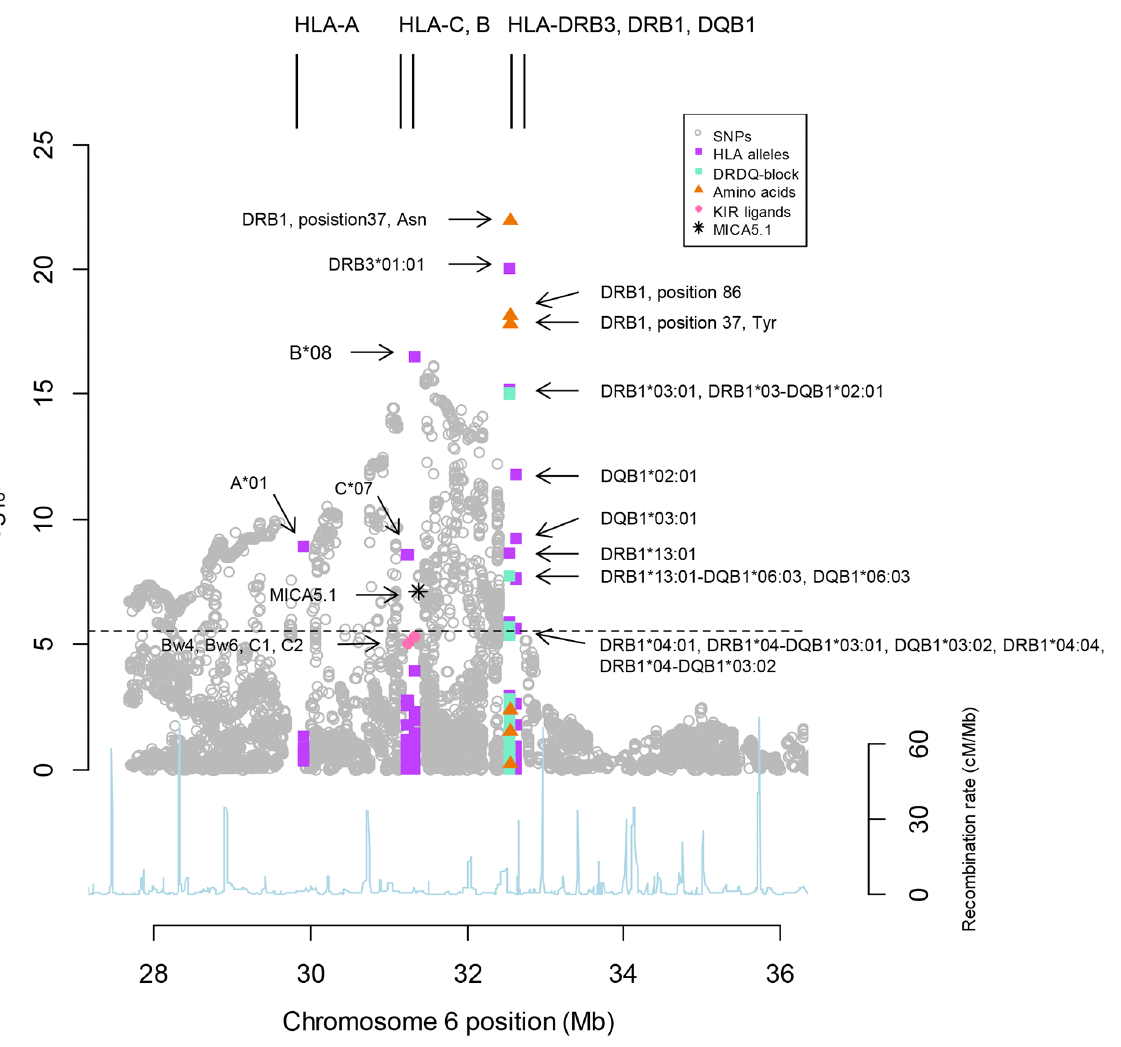
Fig. 1. Single marker association results for presently and previously implicated major histocompatibility complex (MHC) risk variants in primary sclerosing cholangitis (PSC). The strength of association signal, -log 10 P-value (y-axis), is plotted against the position on chromosome 6 shown in million base pairs (Mb, x-axis) for each of the 18,771 variables. The black, horizontal dotted line represents the Bonferroni-corrected statistical significance threshold of P # 2.66 6 10 2 6 . Association results are categorized according to single nucleotide polymorphisms (SNPs), classical HLA alleles, DRB1-DQB1 haplotypes, previously reported amino acids, MICA5.1, as well as variants affecting HLA-B (i.e. Bw4 and Bw6) and HLA-C (i.e. C1 and C2) ligand abilities for killer immunoglobulin-like receptors (KIR). The blue line shows recombination intensity (cM/Mb). Positions are given according to National Center for Biotechnology Information’s build 37